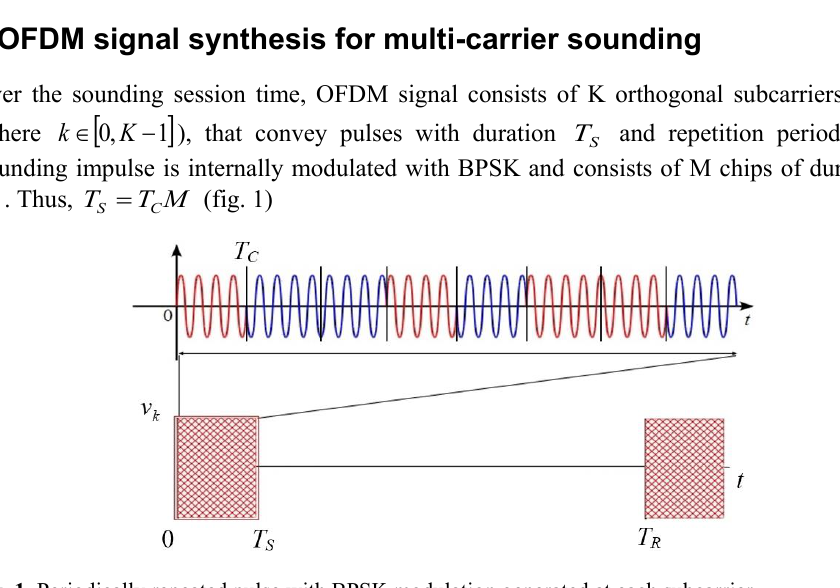
Fig. 1. Periodically repeated pulse with BPSK modulation generated at each